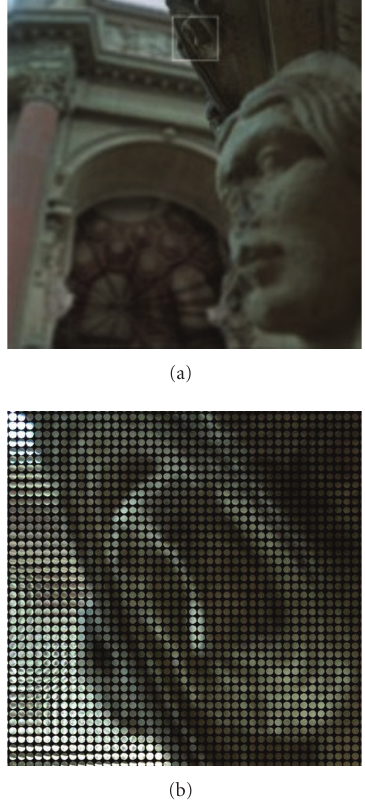
Figure 10: (a) Lightfield captured from a plenoptic camera. (b) Detail from the white square on the left